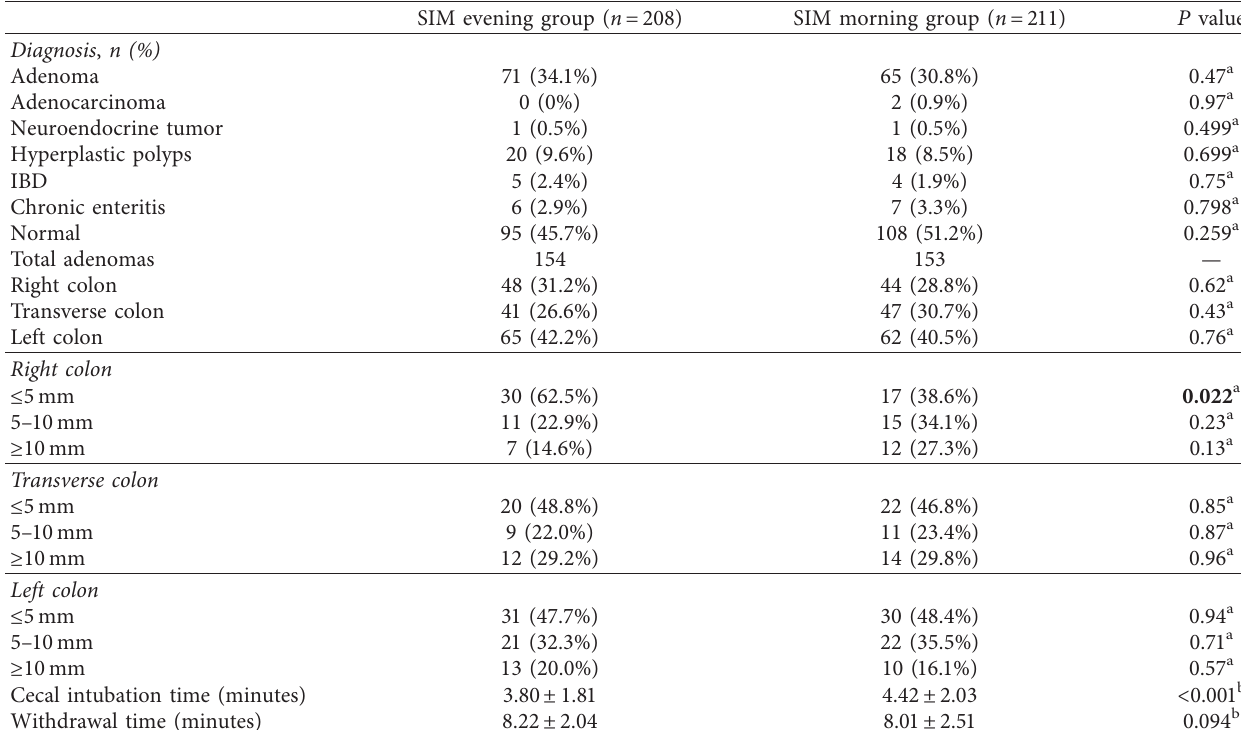
Table 3: Colonoscopy